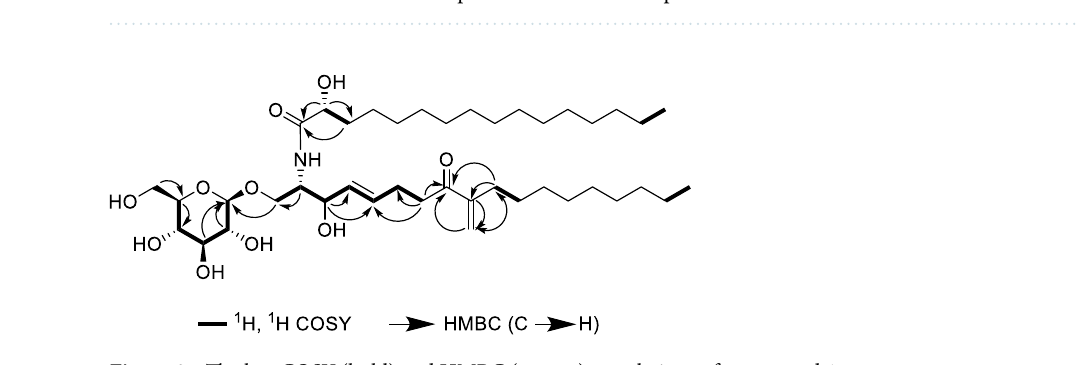
Table 1. The 1 H NMR and 13 C NMR spectral data of the compound 1 in methanol- d4.